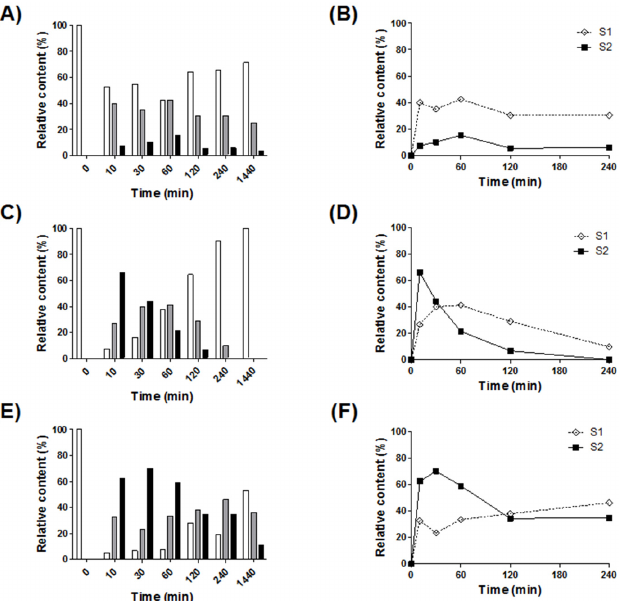
Fig 3. Prolonged incubation of bacterial α (2,6)-ST reaction decreased sialylated glycans. The time- courses of the enzyme reactions were performed at 30°C using Pd- (A and B), P224- (C and D), and P145-STs (E and F). In the bar graphs (A, C, and E), relative contents (%) of G2 (white bar), S1 (gray bar), and S2 (black bar) glycans are represented from 0 – 1,440 min, which were obtained by the calculation of integrated peak areas (100 × [The areas of corresponding glycan peaks]/[Total areas of all identified peaks]). In line graphs (B, D, and F), relative contents (%) of S1 (open diamond) and S2 (filled square) glycans are represented from 0 – 240